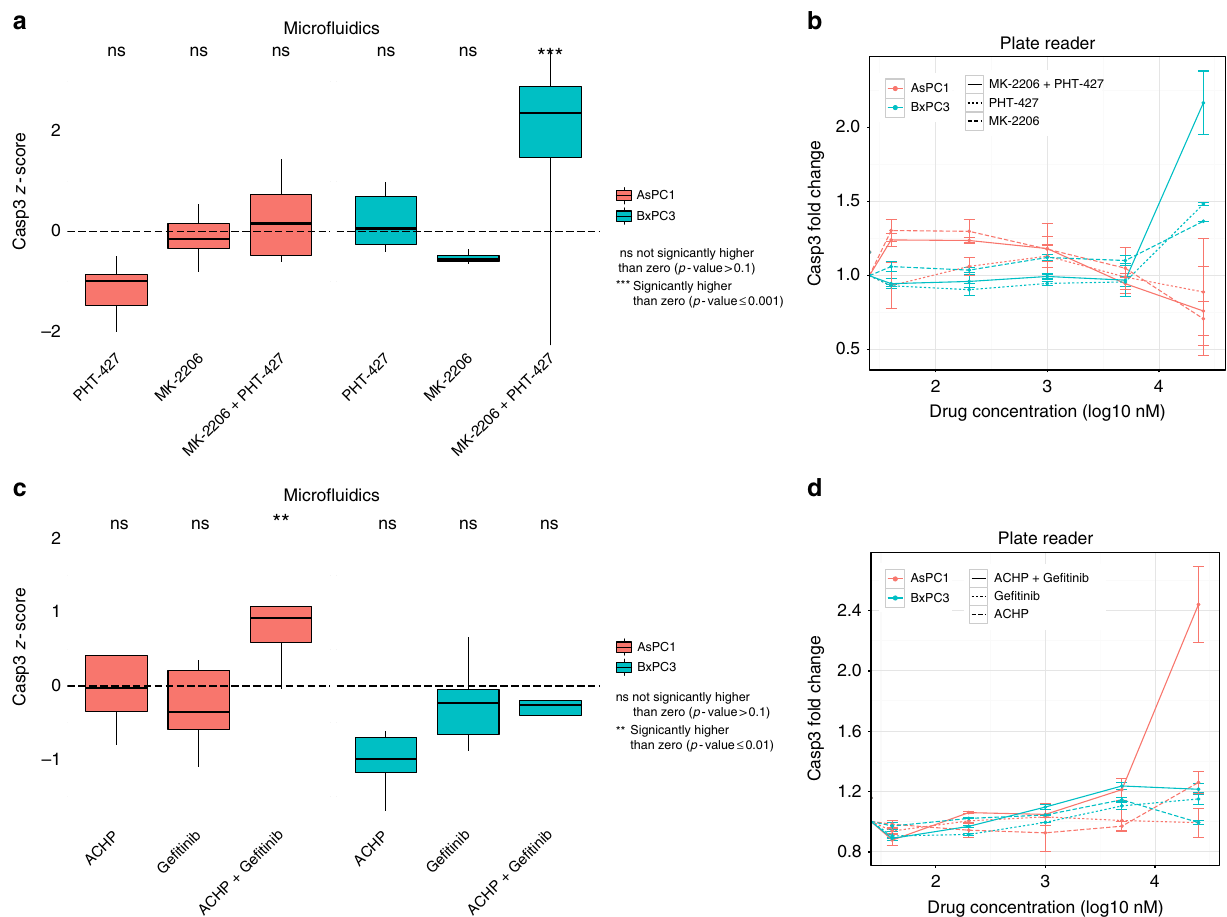
Fig. 4 Validation of cell line-speci fi c drug combinations in tissue culture experiments. a In all boxplots the horizontal line represents the median, the box the interquartile range and the whiskers extend to the most extreme data point which is no >1.5 times the length of the box away from the box. Conditions signi fi cantly higher than zero are marked (** one-tailed t -test; p -value ≤ 0.01). BxPC3 show a strong activation in the micro fl uidic system when treated with the combination of MK-2206 and PHT-427, which is not seen when treated with the single drugs. No strong activation is shown for AsPC1 treated with the same drugs. b Same behaviour is con fi rmed in 96-well plates where the drug combination shows a much higher signal than the two single drug samples for BxPC3 cells, while it stays at the basal level for AsPC1 cells. Error bars represent the standard error of the mean from two replicates. c , d Similarly, the combination of ACHP and Ge fi tinib is potent in AsPC1 cells but not in BxPC3 cells, both in micro fl uidic plugs ( c ) and in a 96-well plate format ( d